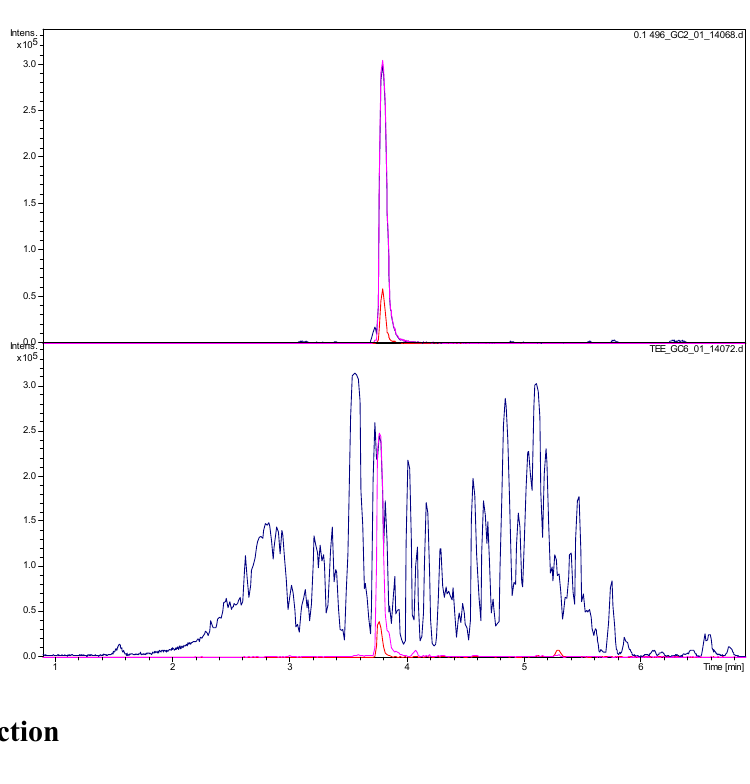
Figure 5. UHPLC/+ESI-QTOF-MSMS analysis of O -tigloylcyclovirobuxeine-B ( 1 ) (top) and of an aqueous decoction as used in ethnomedicine (bottom). Blue: Base peak chromatogram ( m/z 100–1000); Red: EIC m/z 497 [M+H] + ; Magenta: EIC m/z 249 [M+2H] 2+